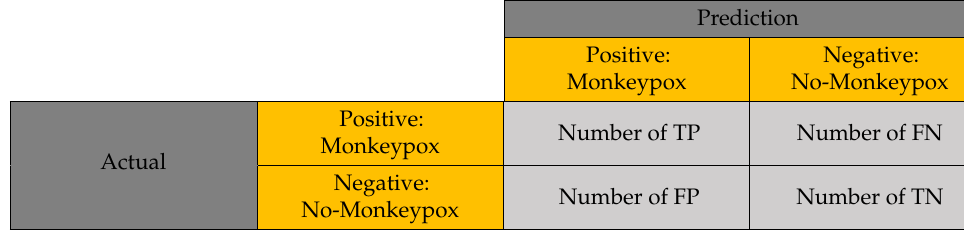
Table 4. Confusion matrix of the mpox